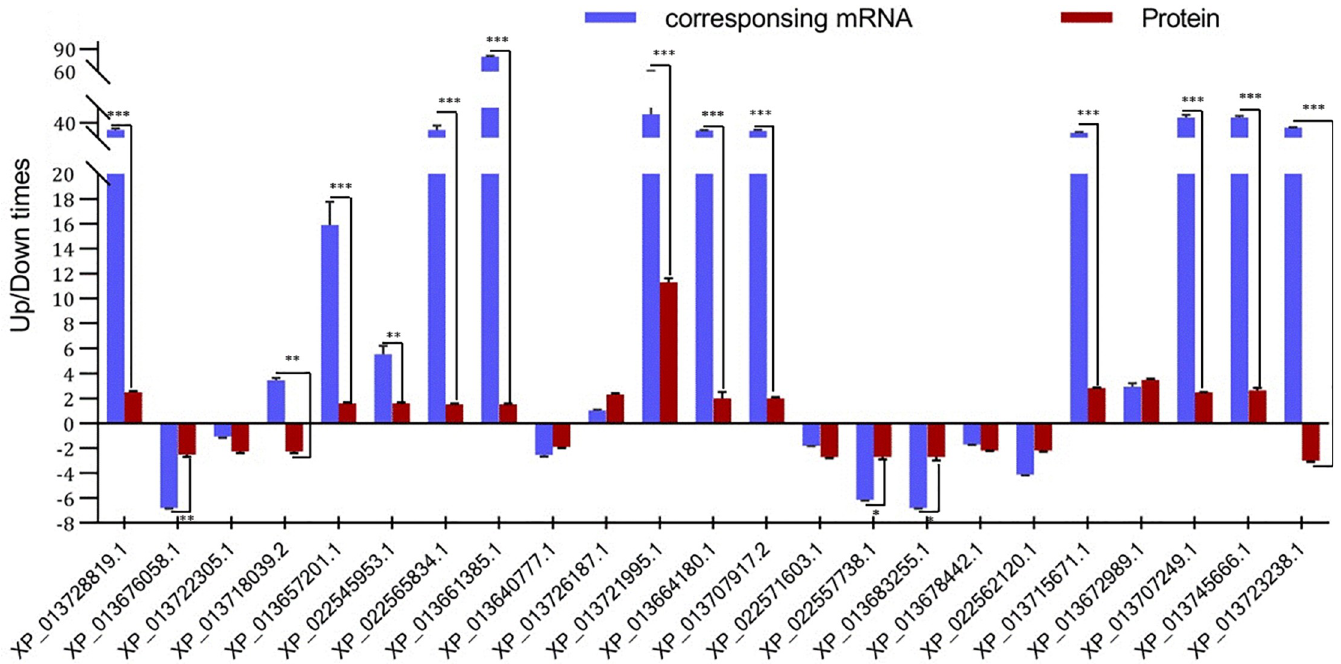
Fig 6. Transcriptional level of selecting corresponding genes of DAPs between two varieties under cold stress. The datas were shown as averages of three independent biological replicates ± SD. � P < 0.05, �� P < 0.01, ��� P < 0.001.